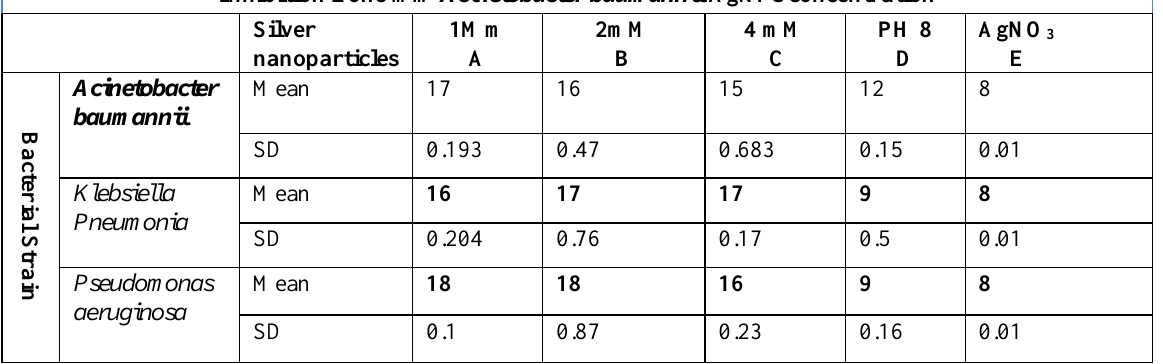
Table 2. Well diffusion assay, inhibition zone of Acinetobacter baumannii biosynthesized silver nanoparticles different formed mixtures measured by mm.